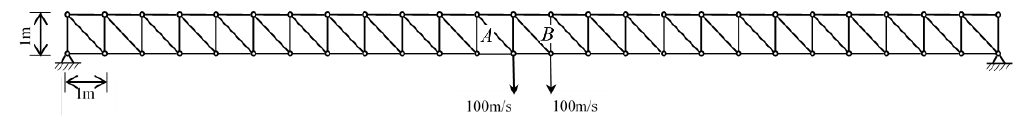
Figure 12. Long span planar skeletal structure.